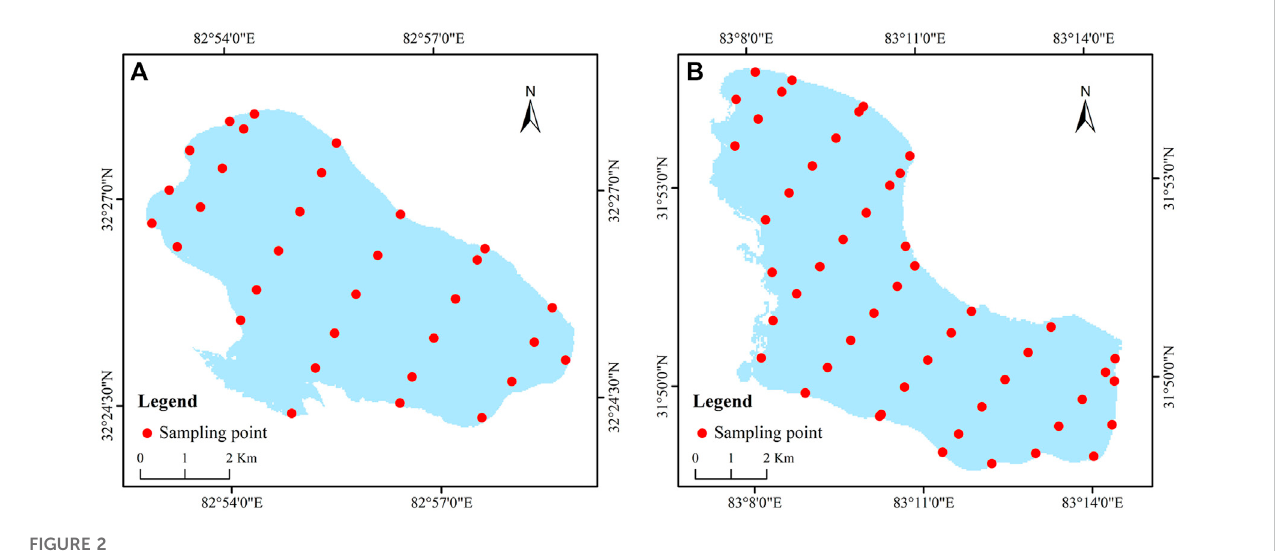
FIGURE 2 The spatial distribution of sampling points. (A) Bieruoze Co. (B) Guopu Co.